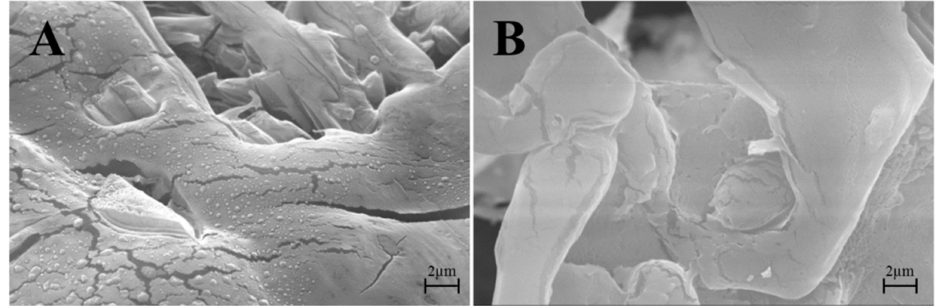
( A ) SEM images of a lyo-secretome batch or ( B ) ultrafiltered and freeze-dried unconditioned